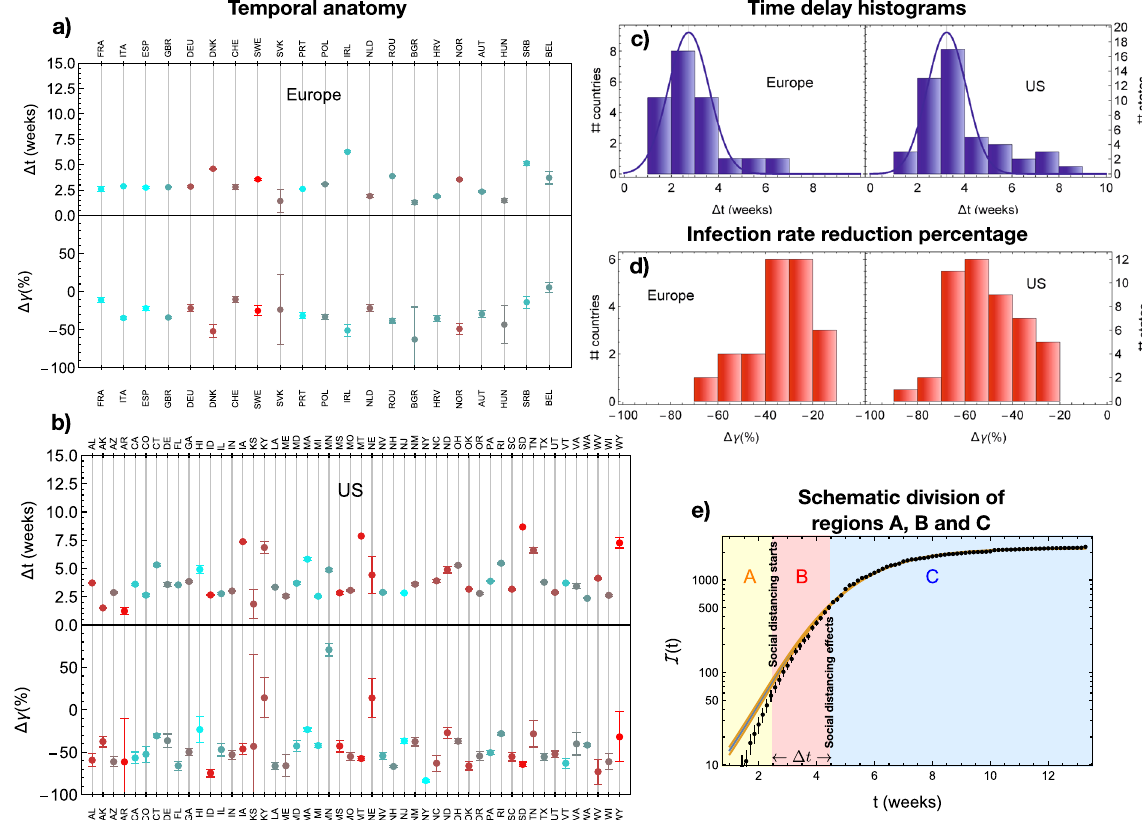
Figure 2. Temporal anatomy of COVID-19 social distancing effects. In panel ( a ), we show (cid:31) t and the percentage variation �γ in the infection rate for the European countries considered in this study. In panel ( b ), we show the same for all the US states. In panels ( c , d ) we display the same results in the form of histograms, for Europe and the US separately, highlighting that (cid:31) t clusters around similar values. In panel ( e ), we illustrate the subdivision of the first wave epidemic curve in three temporal regions: A before social distancing as defined via mobility data occurs, B until an effect is observed in the epidemic curve as a change in γ , and C covering the later times. (cid:31) t equals to the duration of the period